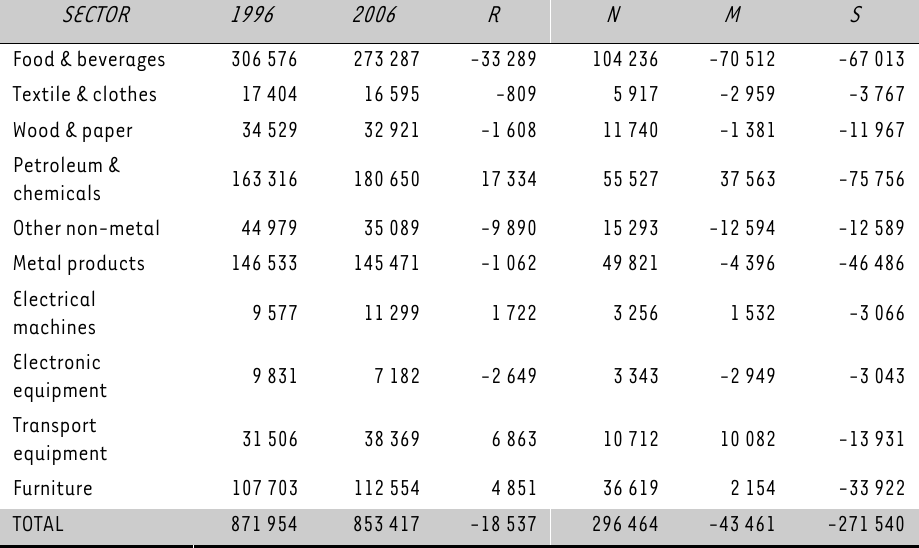
Regional Competitive Share (S), Industry Mix (M), National Share (N) and Total Change in Regional GVA ( × R1 000), Southern District Municipality